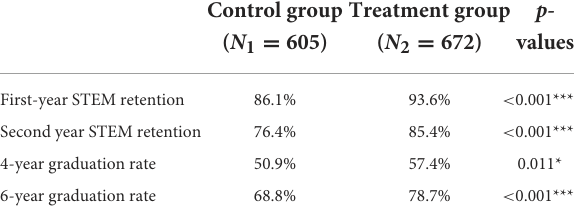
TABLE 2 Success rates for the control group and the treatment group along with the p -values for the two proportion